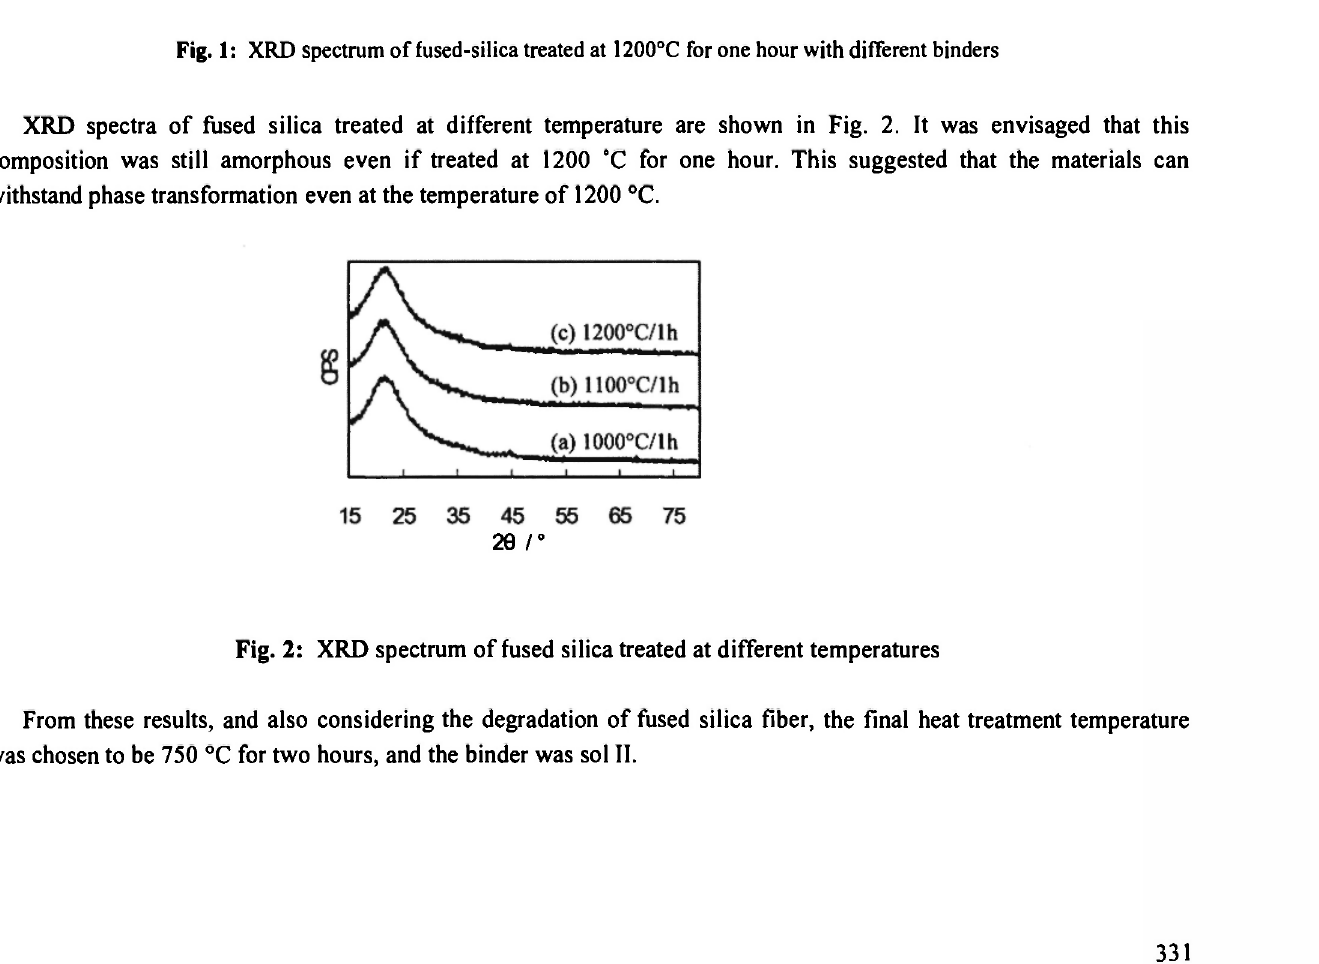
Fig. 2: XRD spectrum of fused silica treated at different